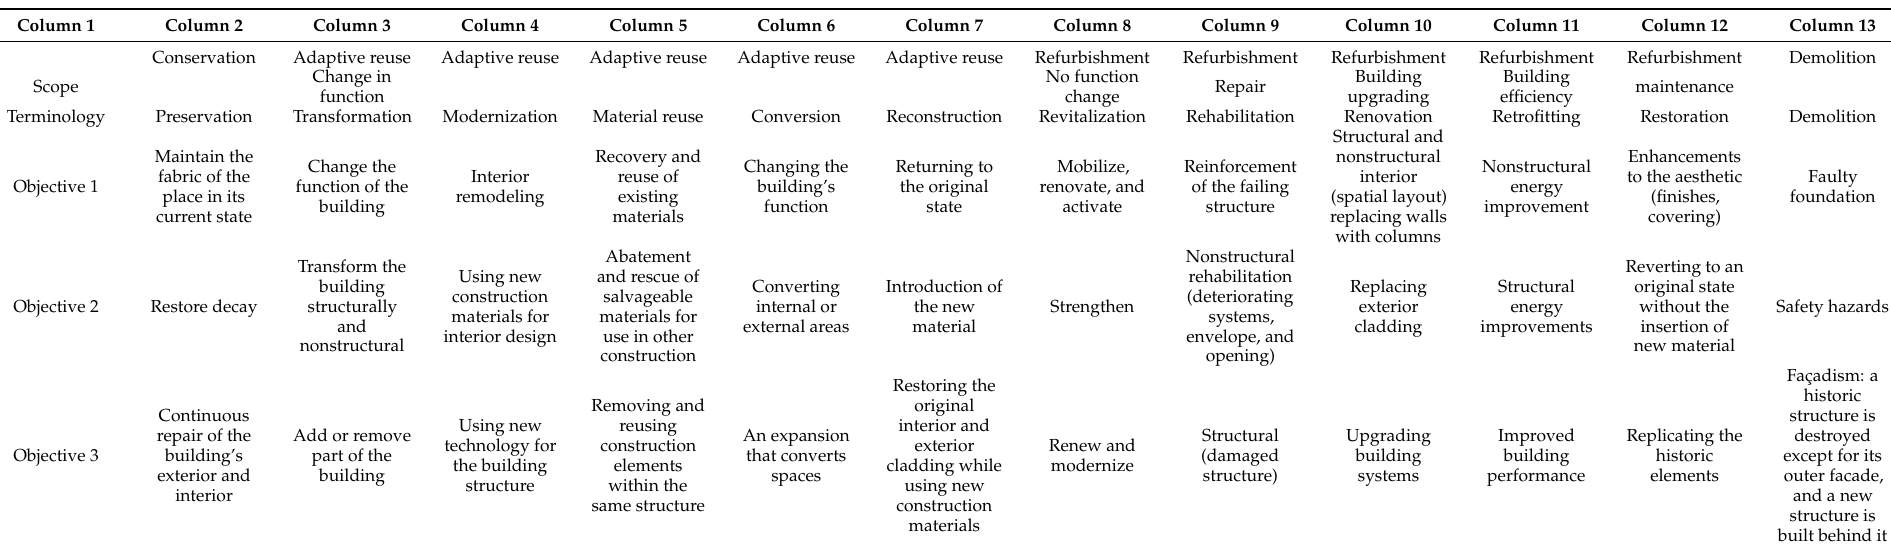
Table 2. Overall framework of the